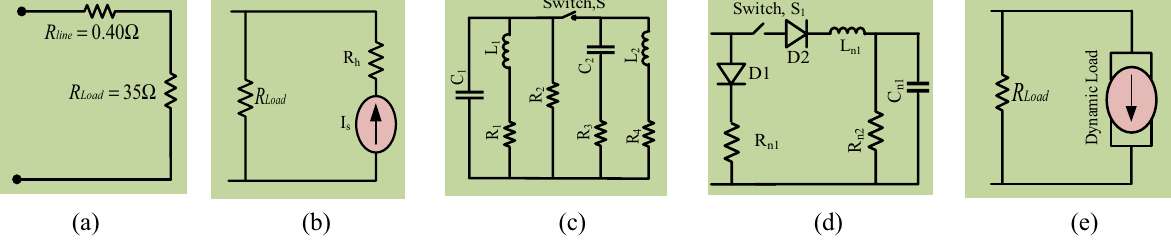
Fig. 10 Block diagram of single‑phase a consumer load, b harmonic load, c unknown load, d nonlinear load, e dynamic load